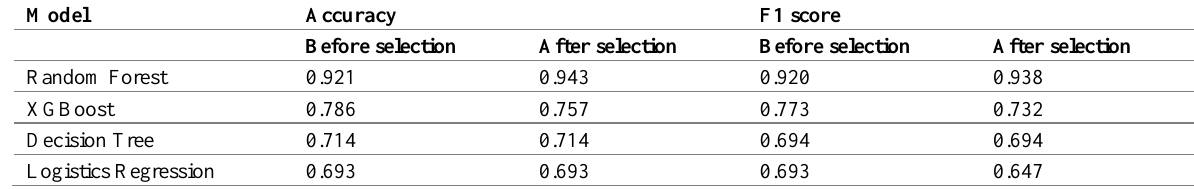
Table 2: Performance Results Before and After Feature Selection